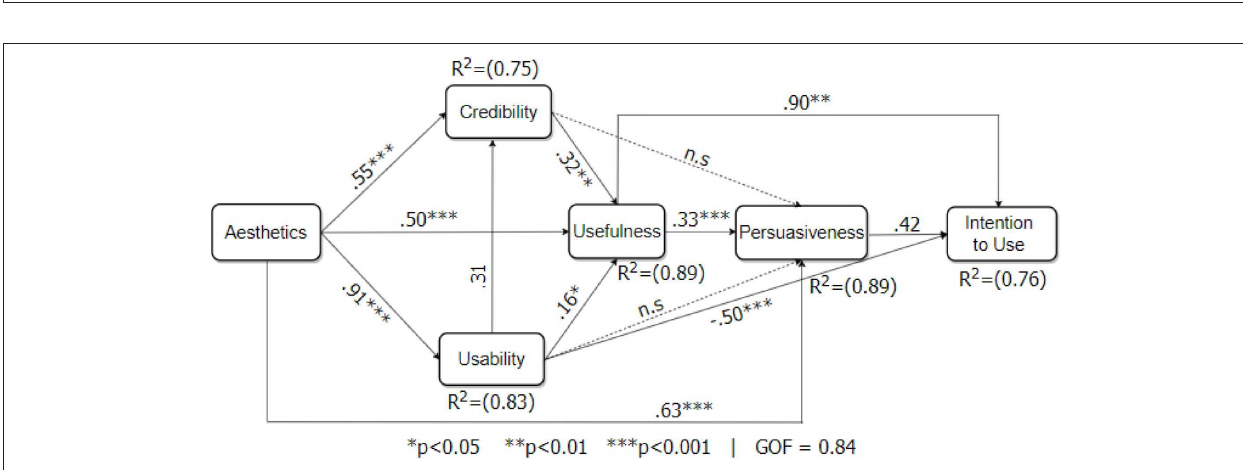
FIGURE 4 | Collectivist persuasive technology acceptance model (for brevity, we have omitted the representation of the non-significant relationships between credibility and intention to